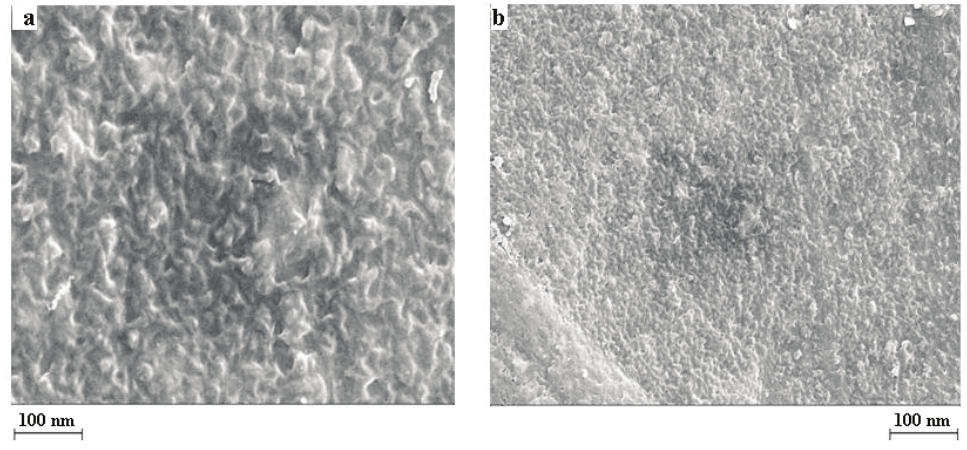
Figure 5. Scanning electron micrographs of PAI-nanocomposite films 5a (a) and 5b